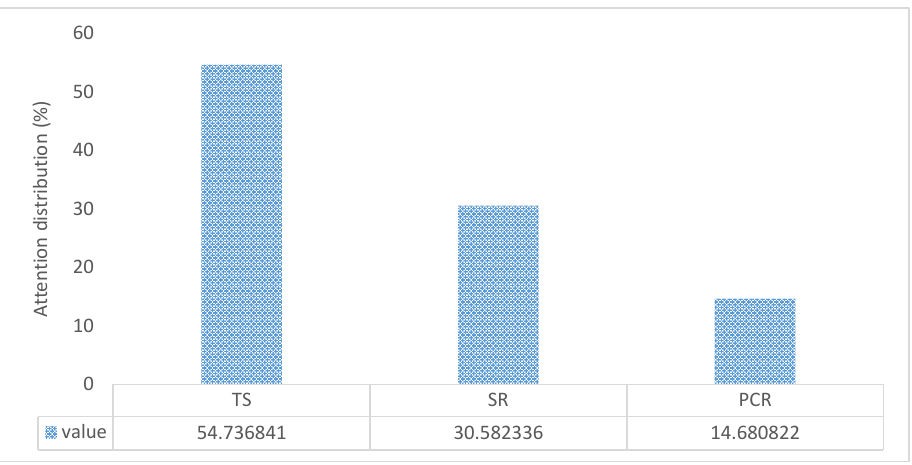
Figure 7. Mean of attention distribution.